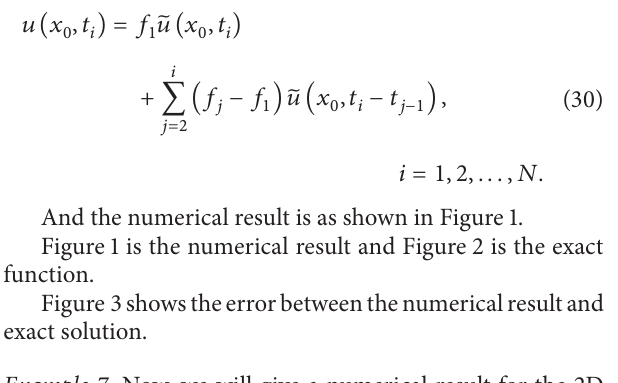
Figure 3: The error between numerical result and exact solution.